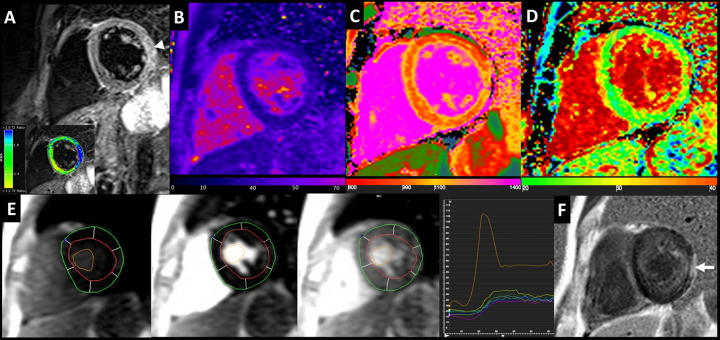
40 years-old male SSc patient (dcSSc pattern) with 13-years history of SSc disease duration.STIR-T2w image shows an area of myocardial edema on left ventricular lateral wall (arrow), emphasized by the analysis of T2 myocardial-to-skeletal muscle signal intensity ratio (box below). Analysis of myocardial T2 (b.), nT1 (c.) and ECV (d.) maps showed T2 value of 51 ± 2.5 ms, a mild diffuse increase of global myocardial nT1 (1050 ± 24 ms) and a slight increase of ECV (33 ± 3.4%). Perfusion images (e.) before, during and after the passage of contrast bolus with relative signal intensity-time curves at different time-points of the myocardial segments and ventricular cavity. LGE image (f.) show a mid-subepicardial enhancement on the lateral wall (arrow).